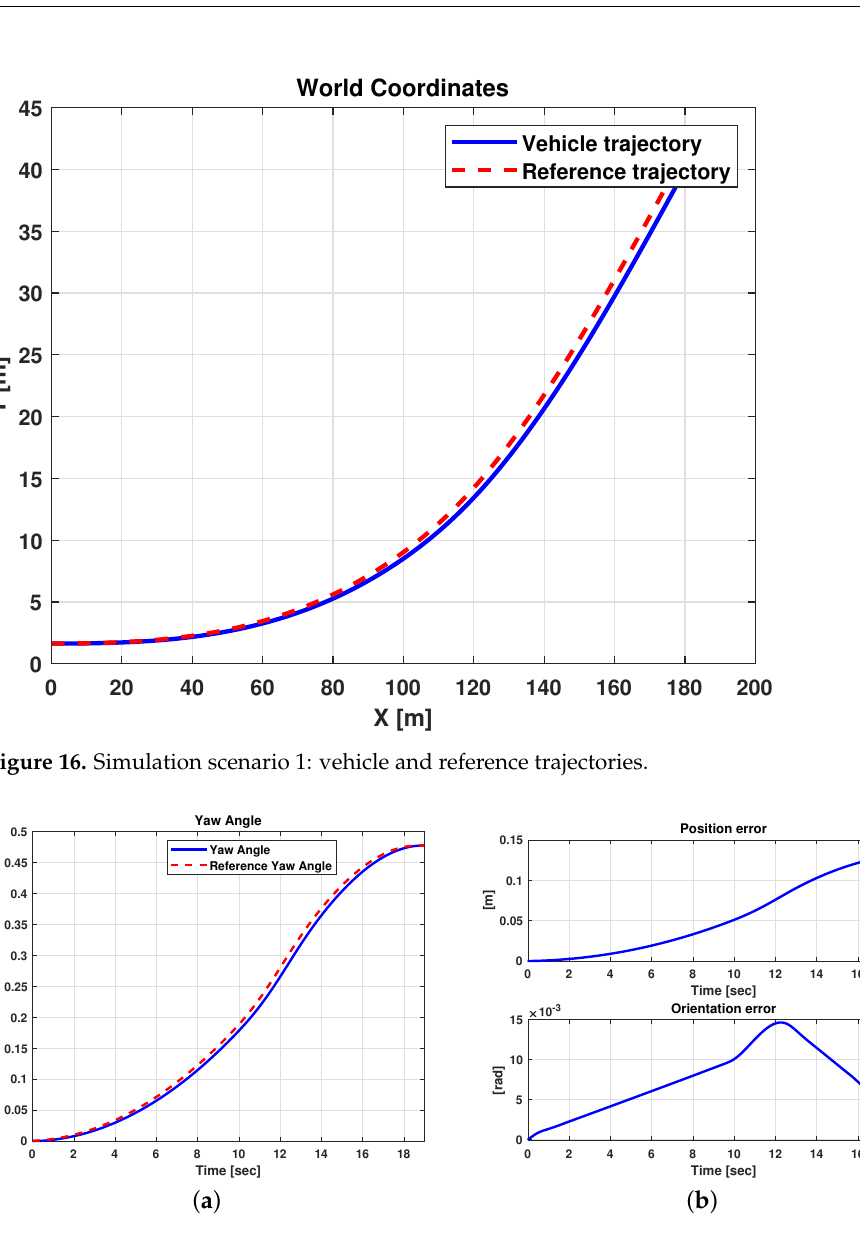
Figure 17. Simulation scenario 1: comparison between reference and measured yaw angles ( a ) and position and orientation errors ( b